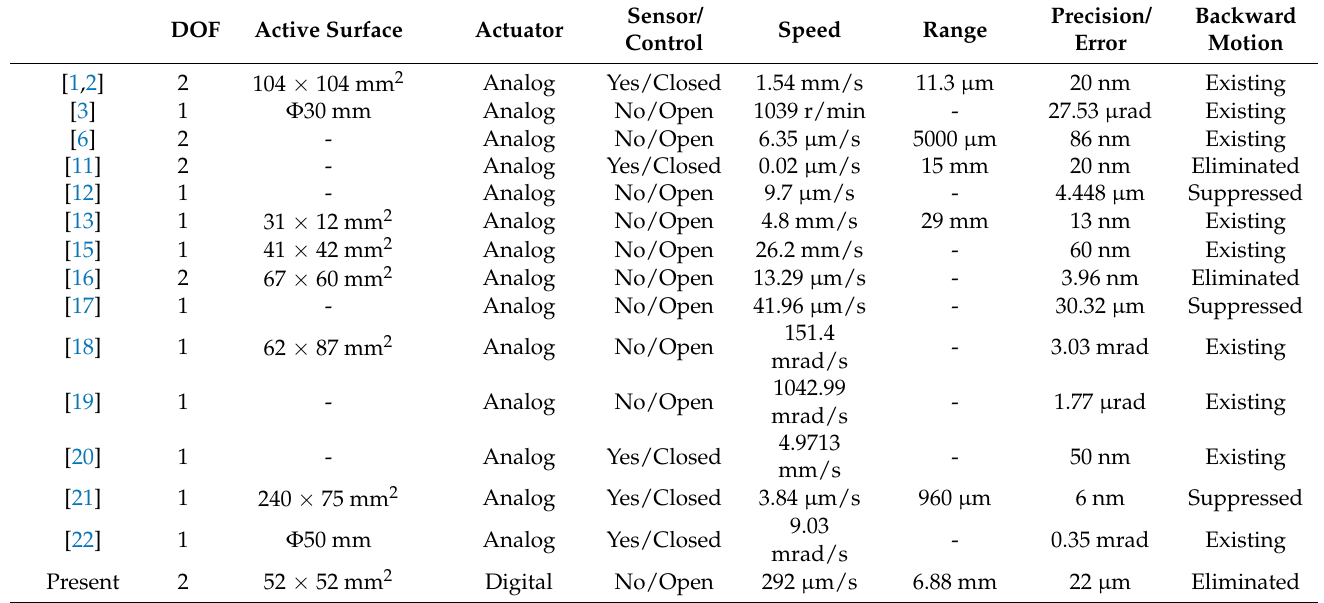
Table 2. Literature